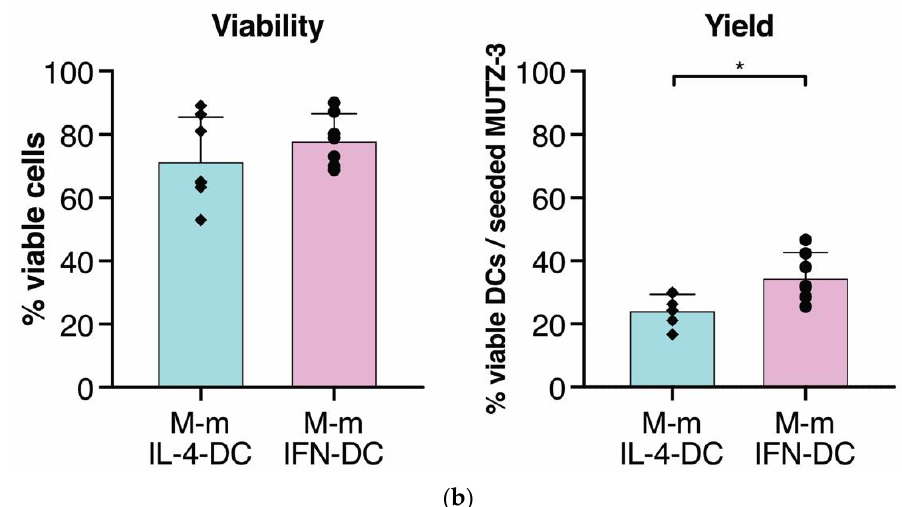
Figure 2. Comparison of cell morphology, cell viability, and yield in mature MUTZ-3-derived IL-4- DCs and IFN-DCs (M-mIL-4-DC and M-mIFN-DC). ( a ) Image of cells observed by phase-contrast microscopy before harvesting mature DCs. The white bar indicates 100 μm. ( b ) Live and dead cells were measured by trypan blue staining to compare the viability and yield of the MUTZ-3-derived DCs/seeded MUTZ-3 ( n = 7). The bars indicate the mean ± S.D. of independent experiments. * p < 0.05 indicates a statistically significant difference compared to M-mIL-4-DC. The rhombus in the Scatter plot is MUTZ-3 derived IL-4-DCs. Circle is MUTZ-3 derived IFN-DCs.